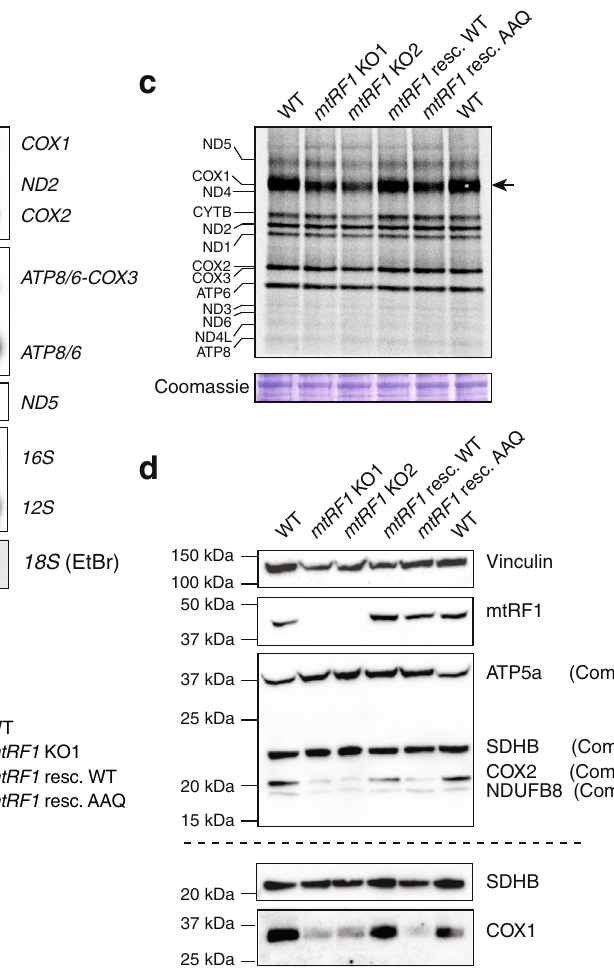
proteins in WT, mtRF1 KO and mtRF1 rescue cells analyzed by [ 35 S]-labeling (the same gel as in Fig. 2e is shown). The arrow highlights differences of COX1 protein synthesis between WT, mtRF1 KO and mtRF1 rescue cells. Loading wasassessed by Coomassie staining. n =1 experiment. d OXPHOS protein levels analyzed by wes- tern blotting. 100 µ g of whole-cell lysates were loaded. Membranes were probed with the OXPHOS antibody cocktail (upper panel) and anti-COX1 antibody (lower panel). The expression of mtRF1 in rescue cells was con fi rmed by the anti-mtRF1 antibody. Loading wasassessed by Vinculin/SDHBdetection. A representative blot of n =3 independent experiments is